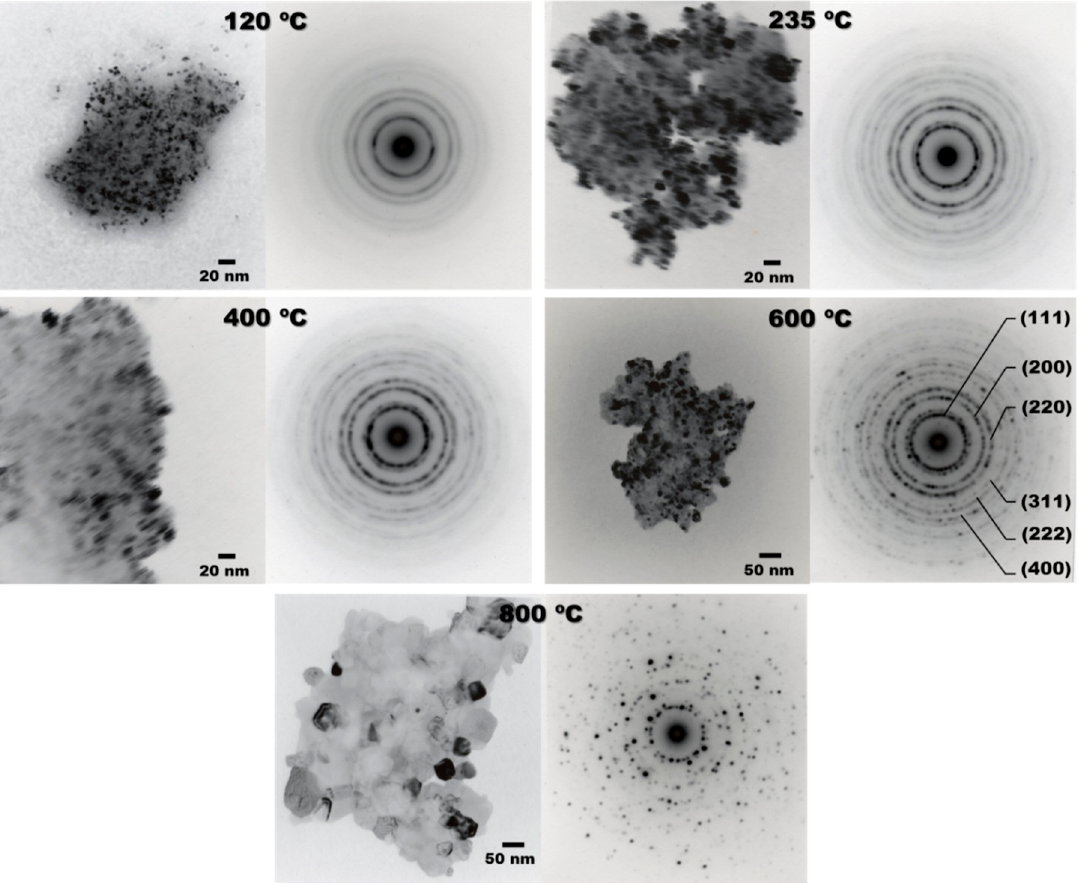
Figure 5. TEM images and SAEDPs of nanocrystalline CeO 2 powders thermally treated at different temperatures.